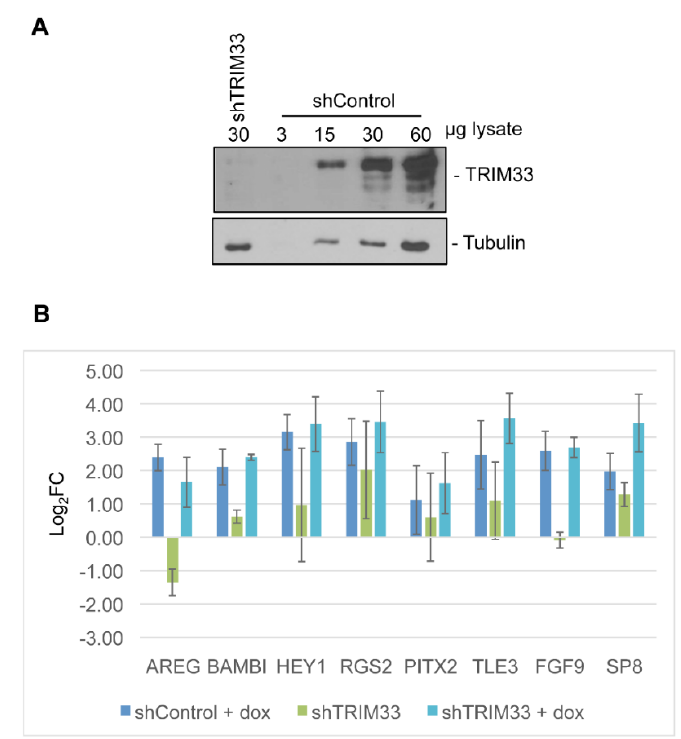
Figure 6. Loss of TRIM33 does not prevent the up-regulation of E4-ORF3 target genes. ( A ) Pools of Tet-E4-ORF3 cells were stably infected with retrovirus that express short hairpin RNA directed against TRIM33 or a nonspecific control. 60, 30, 15, and 3 μ g of shControl lysate were loaded on a polyacrylamide gel with 30 μ g of shTRIM33 and subject to Western blot analysis; ( B ) shTRIM33 and shControl cells were mock-treated or supplemented with dox to express E4-ORF3 for 24 h. Transcript levels were recorded by relative quantification RT-qPCR. Bars represent log 2 fold change in expression in mock-treated shTRIM33 cells, dox-induced shTRIM33 cells, or dox-induced shControl cells, relative to mock-treated shControl cells, normalized to GAPDH. Error bars = S.D., n = 3. No statistically significant difference in transcript levels could be detected between dox-induced control cells and dox-induced shTRIM33 cells as determined by one-way ANOVA analysis with multiple